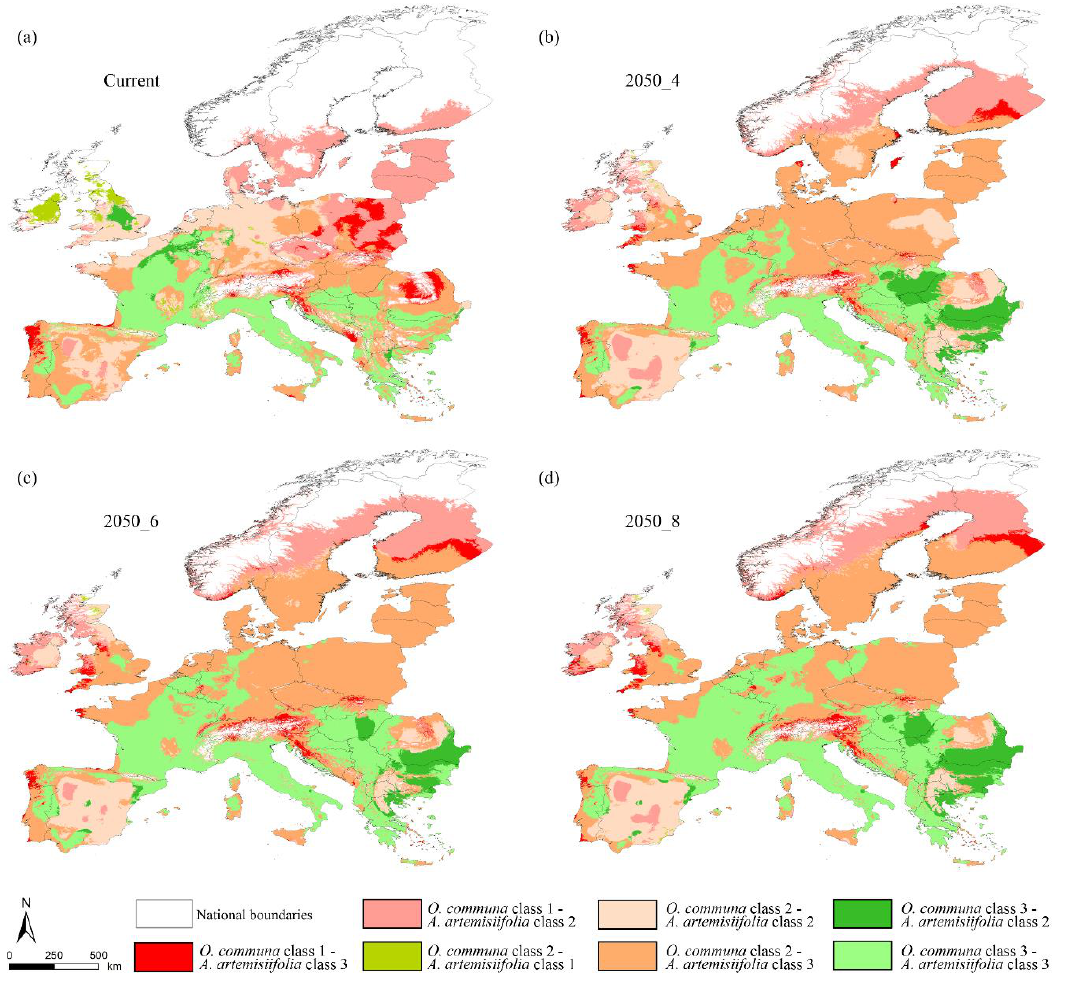
Figure 7. Territories of overlapping classes of suitability (class 1 = low; class 2 = medium; class 3 = high) for Ambrosia artemisiifolia and Ophraella communa in the different time frames considered (( a ) ( b ) 2050 RCP 4.5; ( c ) 2050 RCP 6.0; ( d ) 2050 RCP current; ( b ) 2050 RCP 4.5; ( c ) 2050 RCP 6.0; ( d ) 2050 RCP 8.5).